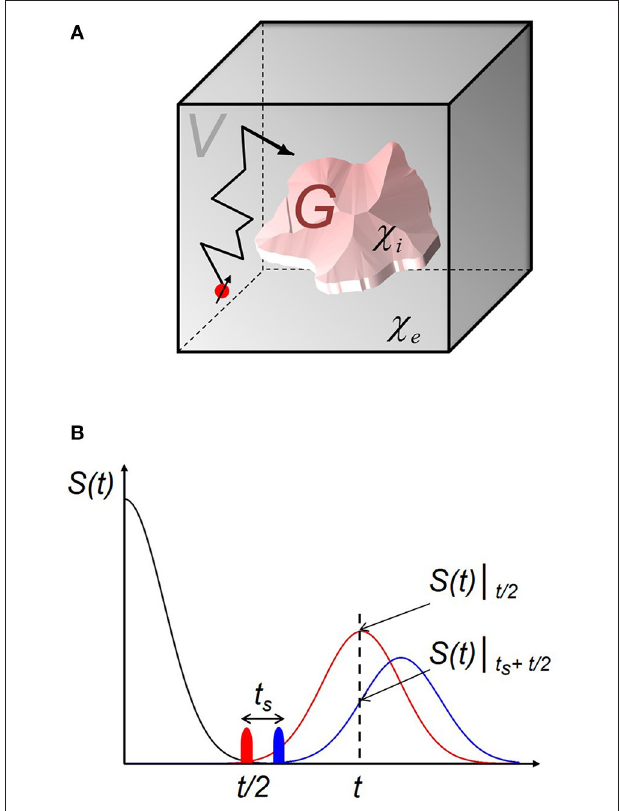
FIGURE 1 | Proton spin trajectory around a magnetized object and measurement of the frequency correlation function through asymmetric spin echos. (A) Magnetized object G with susceptibility χ i embedded in a surrounding medium V with susceptibility χ e ; both volumes G / V Voxel . constitute the voxel volume V Voxel and the volume fraction is η = The spin is subjected to stochastic field fluctuations in V induced by a distortion of the magnetic field from object G . (B) The corresponding ω ( t ) ω (0) frequency correlation function K ( t ) , where the bra-ket-formalism = h i indicates averaging over all protons inside the voxel, determines the MR-signal S : through measurement of asymmetric spin echos, i.e., spin echos S ( t ) that are shifted with time t s away from the standard spin echo value | t s + t / 2 t S ( t ) of t / 2 (see main text) we have S ( t ) exp 2 t 2 s K 2 | t s + t / 2 = | t / 2 − (cid:17)(cid:17) (cid:16) (cid:16)